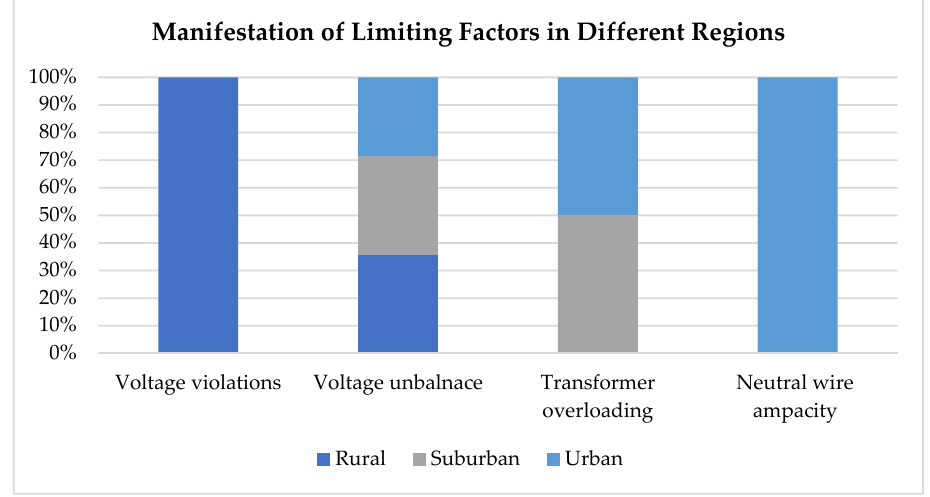
Figure 5. Quantitative analysis of HC limiting constraints for the investigated cases in Section 4.1.2.